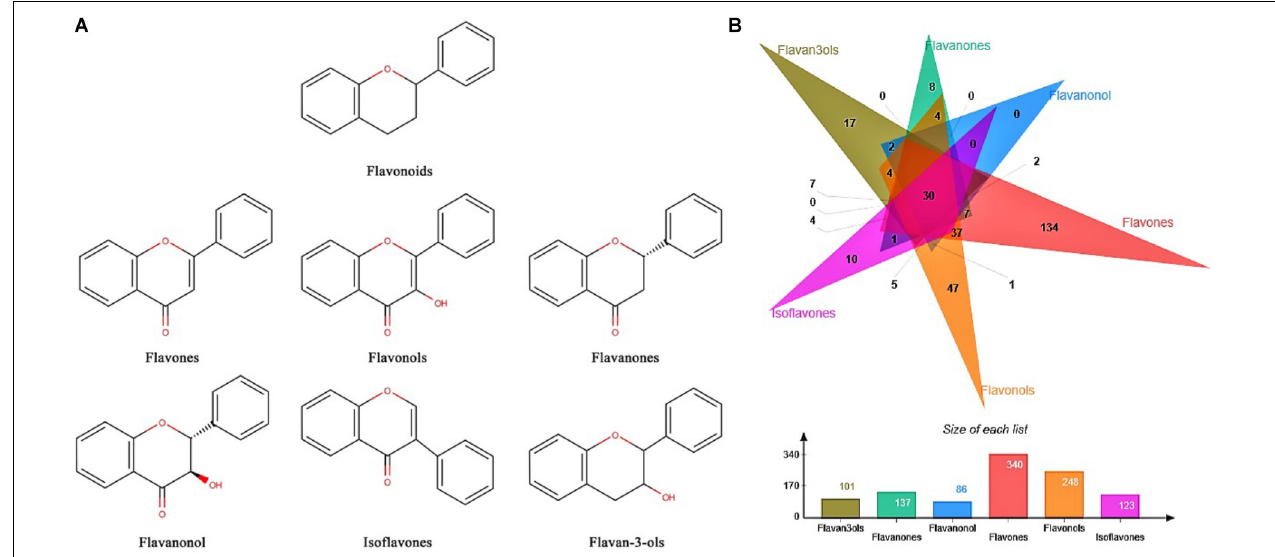
FIGURE 1 | Structures and targets information of flavonoids. (A) Core scaffold structures of six flavonoid subclasses. (B) Target number of different flavonoid subclasses.